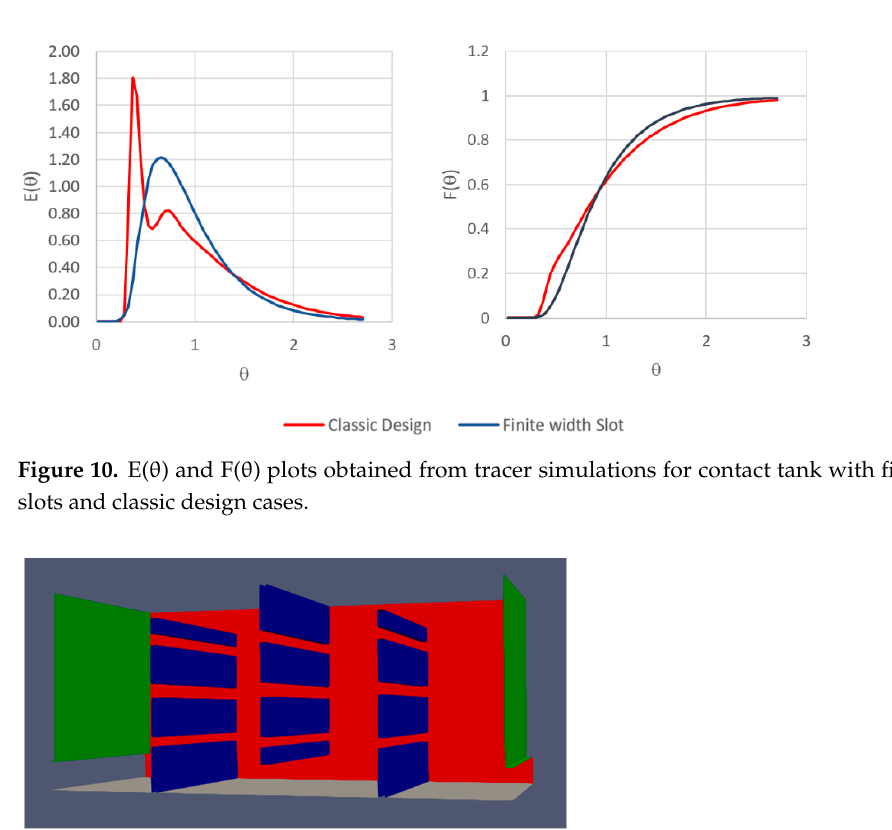
Figure 11. Typical contact tank baffle configuration for baffles with full width slots (w = 230 mm, h = 12, 16, 14 mm random placement) case.